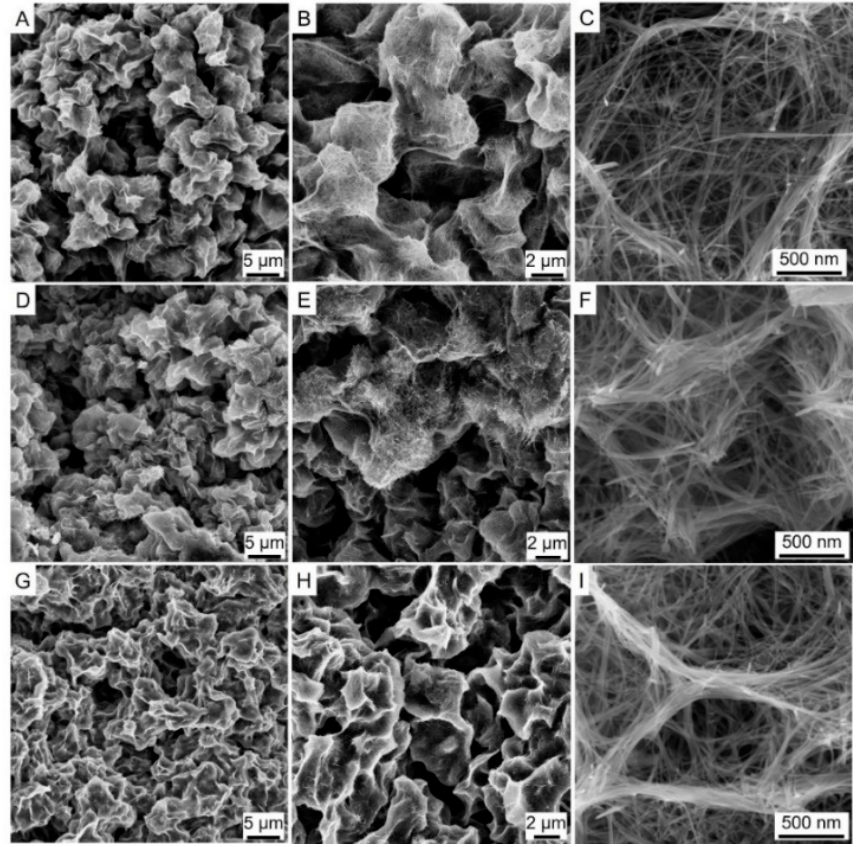
Figure 3. The Scanning Electron Microscopy (SEM) images of pristine MnO 2 ( A–C ), Ni-MnO 2 ( D–F ), and Co-MnO 2 ( G–I ) samples.